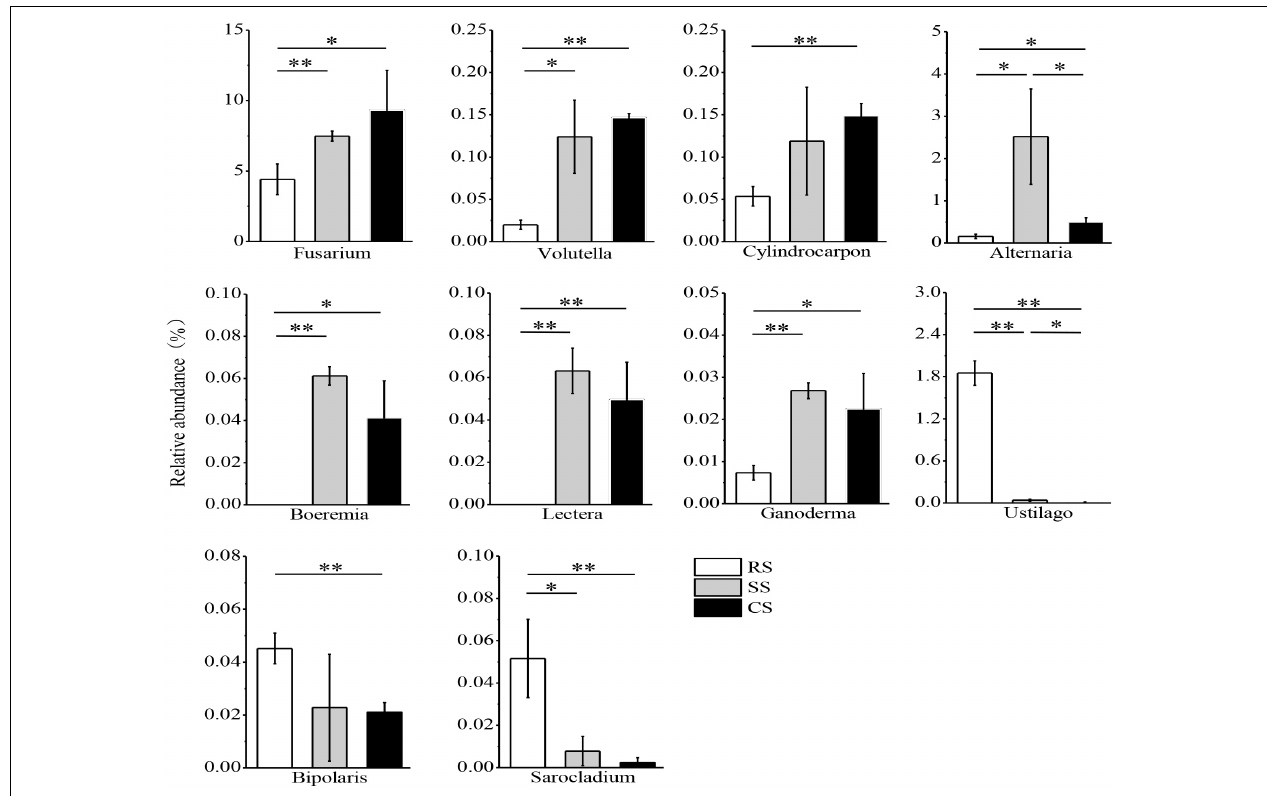
FIGURE 6 | Relative abundance of potentially pathogenic fungi in three soybean cropping systems. ∗ P < 0.05, ∗∗ P < 0.01 by Student’s t -test (equal variance). RS, SS, and CS represented soybean rotation with a 3-year cycle of wheat, maize and soybean, short-term continuous soybean cropping with 1-year wheat and 2-year soybean, and long-term continuous soybean cropping,